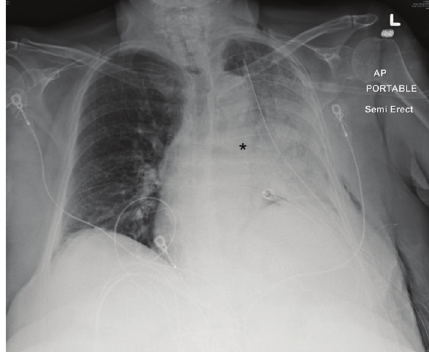
Figure 2: Portable chest radiograph obtained on postop day-2 showingleftlungopacificationwithbronchialcutoff(blackasterisk).